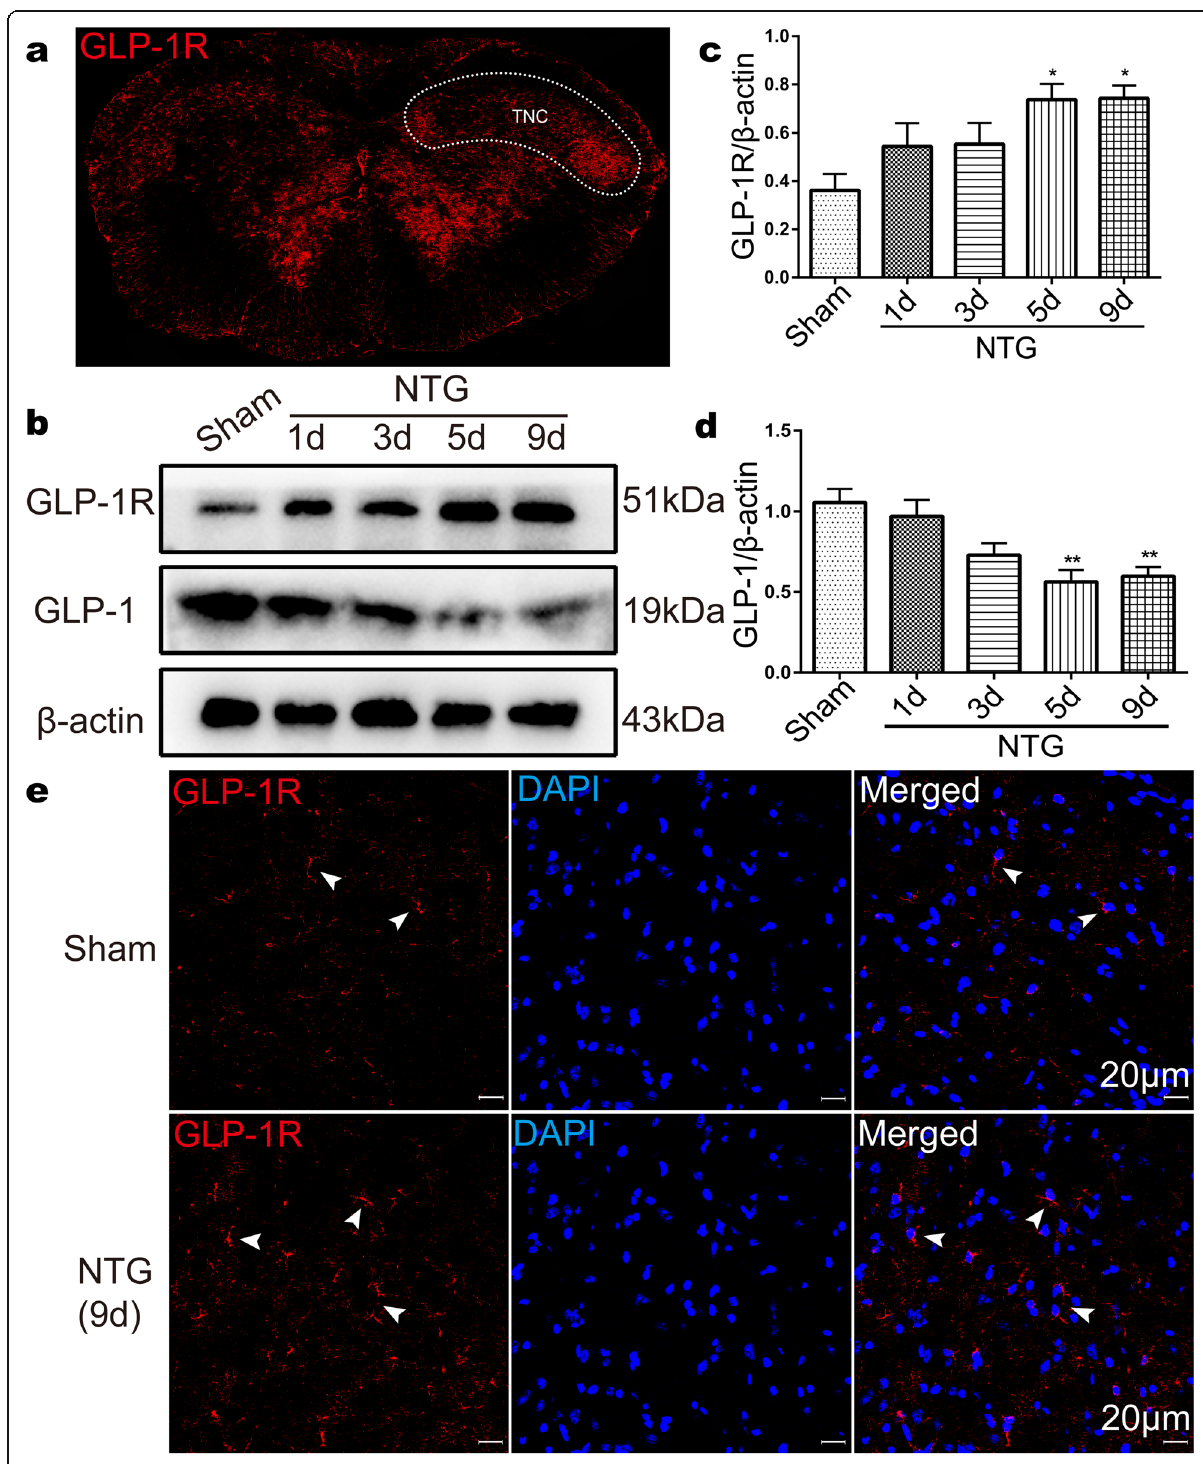
Fig. 1 Recurrent NTG injection increased GLP-1R expression in the TNC. a The white dotted line frame exhibits the TNC regions. b-d Representative western blot showing changes in GLP-1R and GLP-1 protein expression in the TNC on different days after NTG injection ( b ). The band intensities are presented as the percent (%) change relative to β -actin ( c-d ). Data are presented as mean ± SEM; n = 6/group; * p < 0.05, ** p < 0.01 vs. sham group. e Representative immunofluorescence images of GLP-1R in the TNC in the sham and NTG (9d) groups. Arrowheads indicate GLP-1R. n = 3/group, scale bar: 20 μ